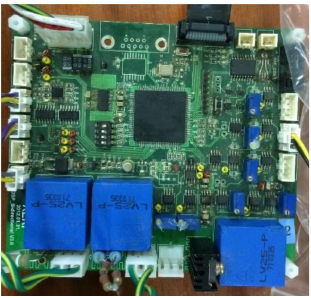
Figure 10. Digital control